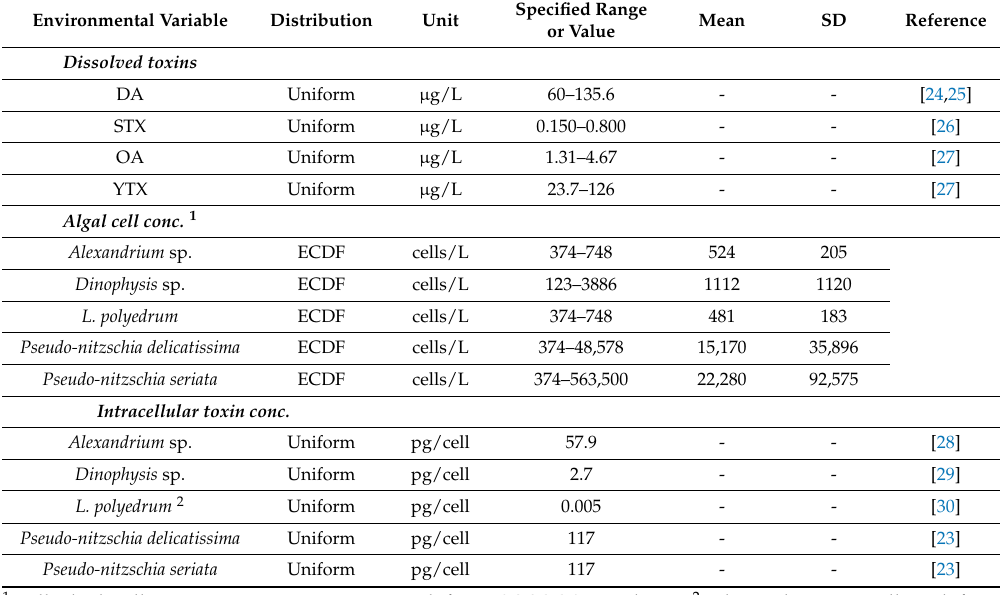
Table 1. Concentration of dissolved marine toxins, toxin producing algal cells and intracellular toxin per cell used in the pMFA